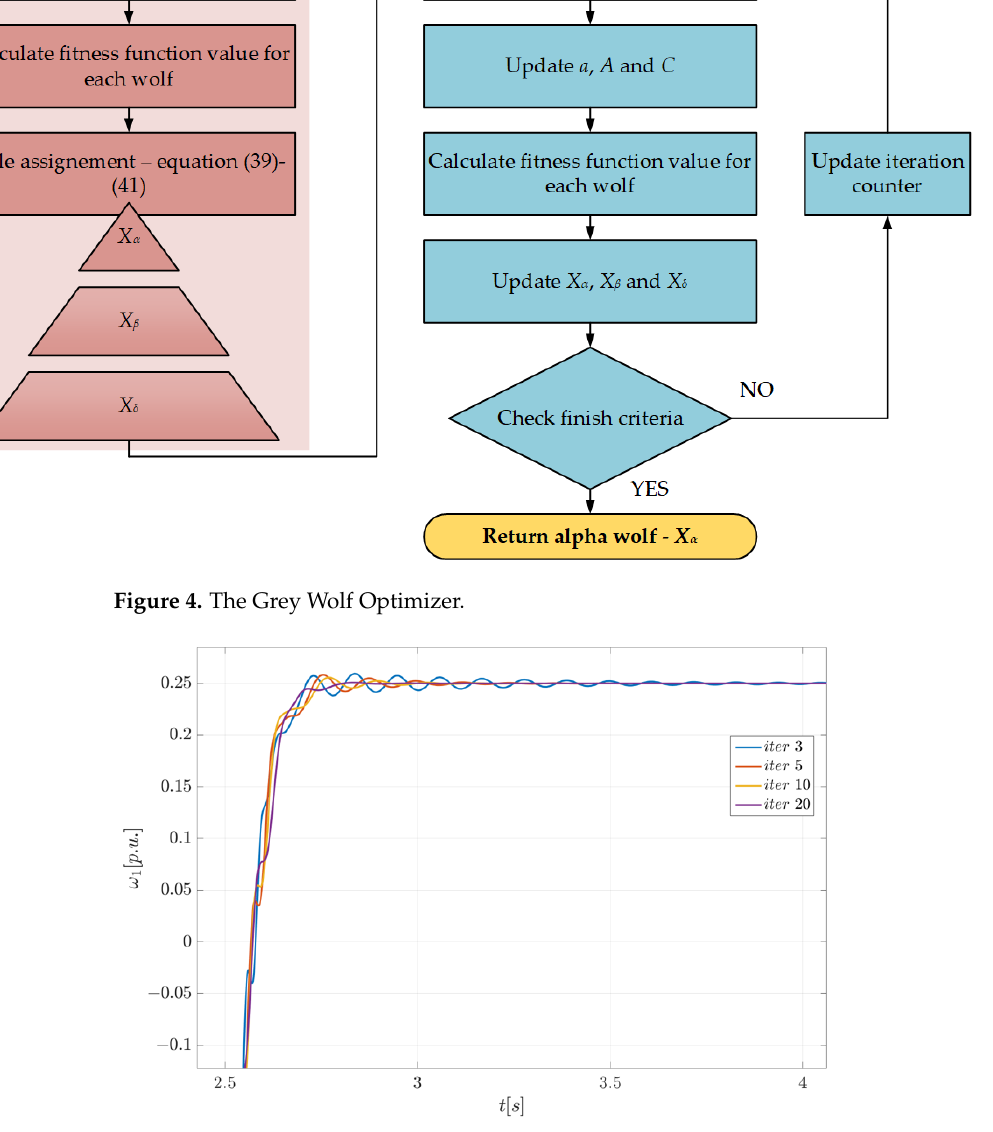
Figure 5. Speed transients’ changes during optimization. Table 1. The values of the fitness